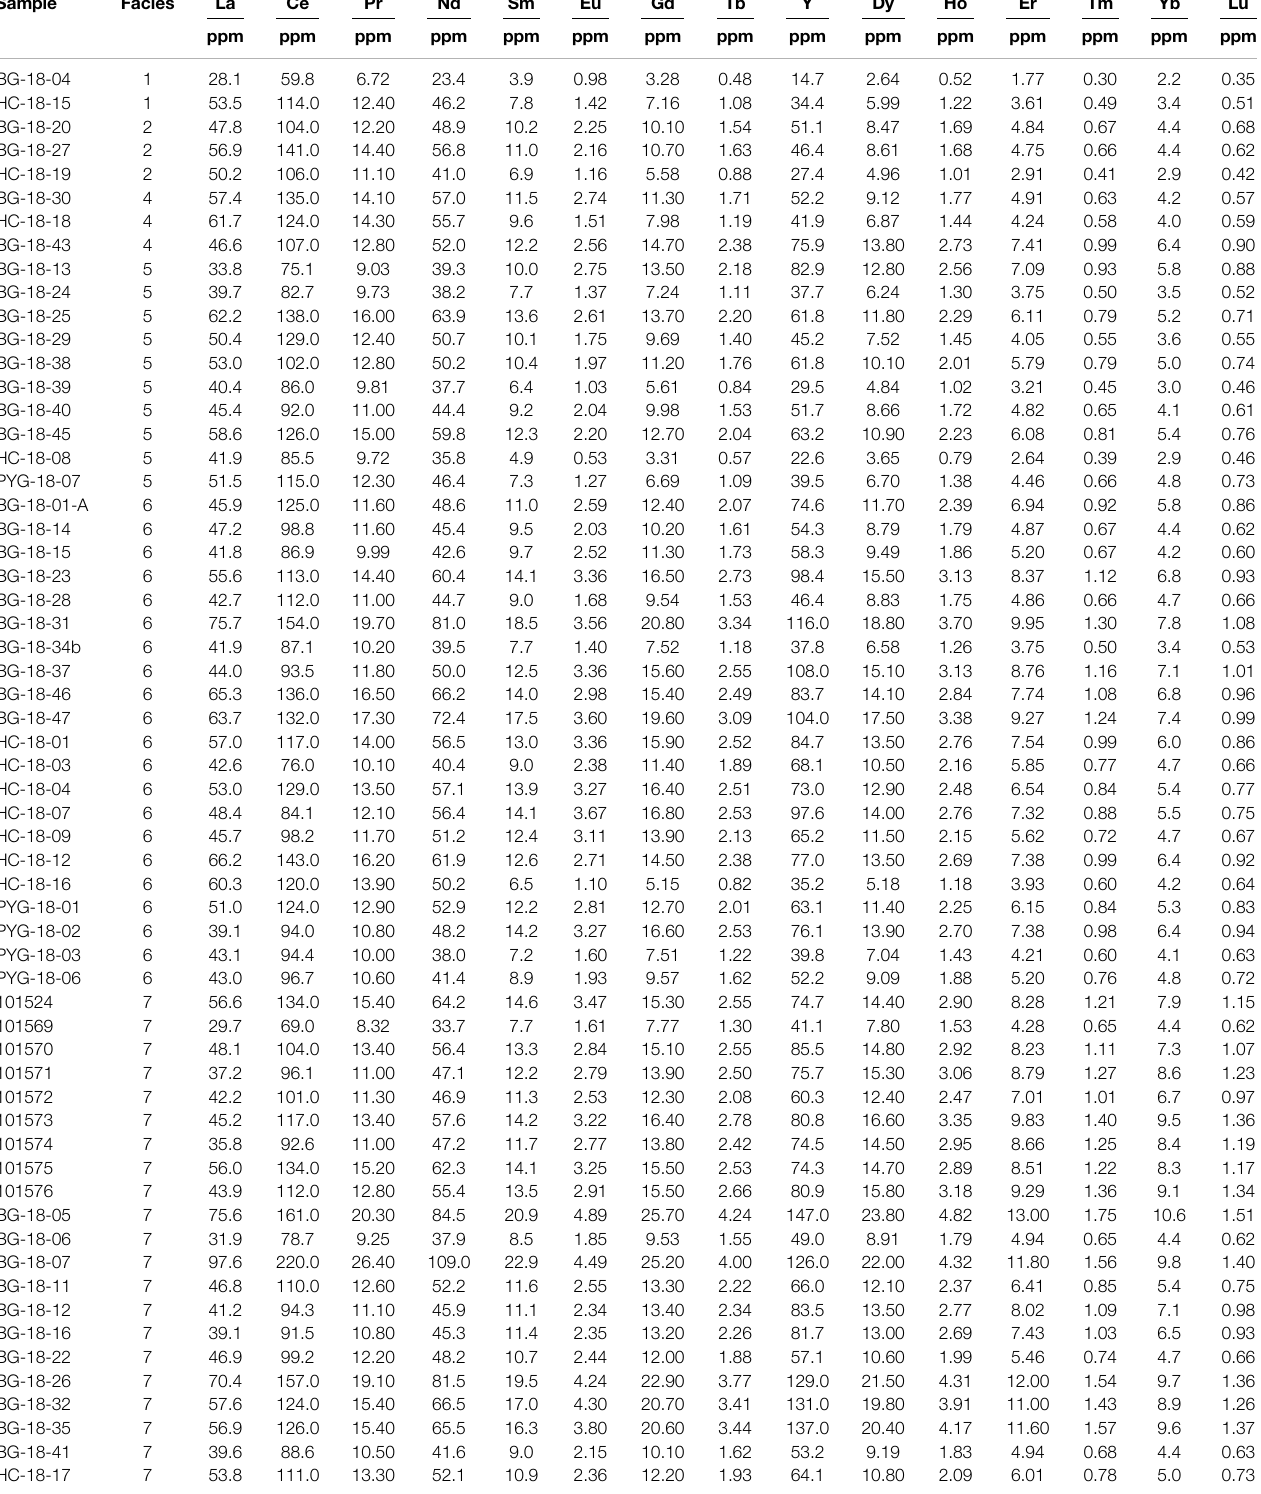
TABLE 2 | REE + Y concentrations in lithofacies of the Hen-dy-Capel Ironstone Member, Tygarn Formation.